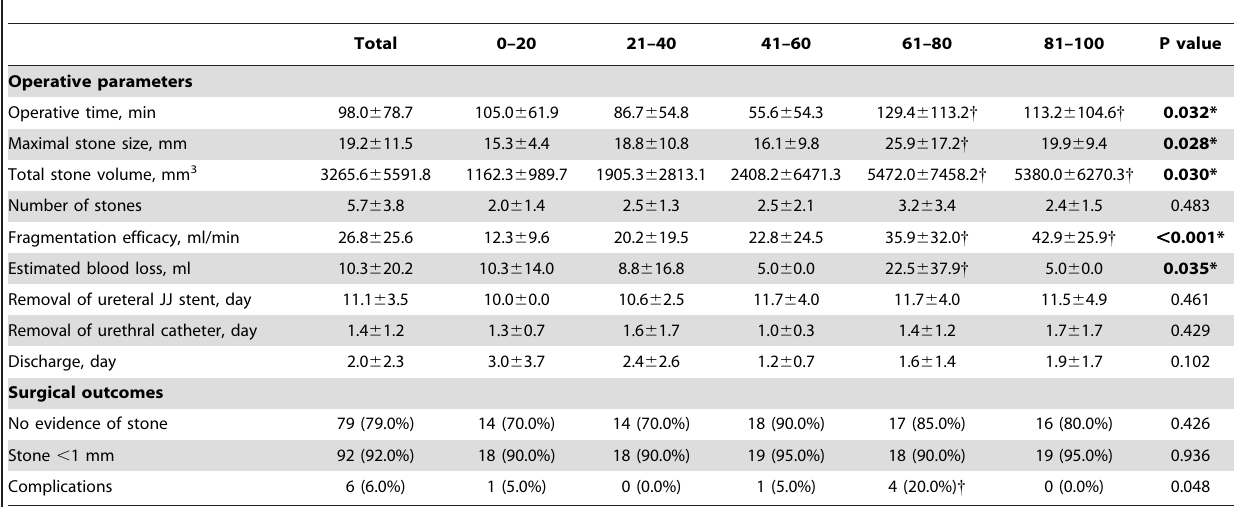
Table 2. Perioperative findings and surgical outcomes according to the number of cases.